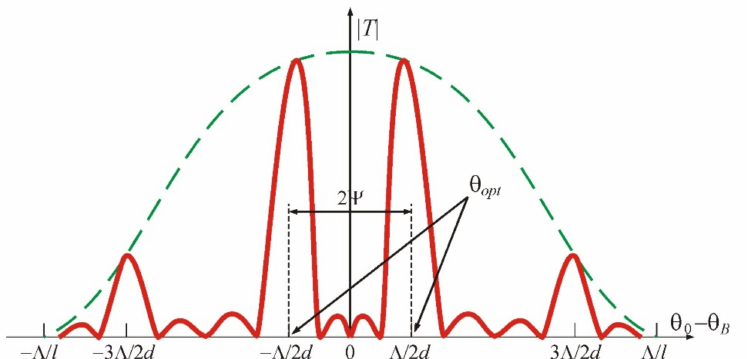
Figure 2. Radiation patterns of four-sectioned (red line) and one-sectioned (green line) transducers. As follows from Equation (1), when the ultrasound frequency decreases, the main lobes of the transducer radiation pattern diverge. Therefore, if one chooses the true angle of light incidence, the equivalent wavefront will rotate, adjusting to the changing Bragg